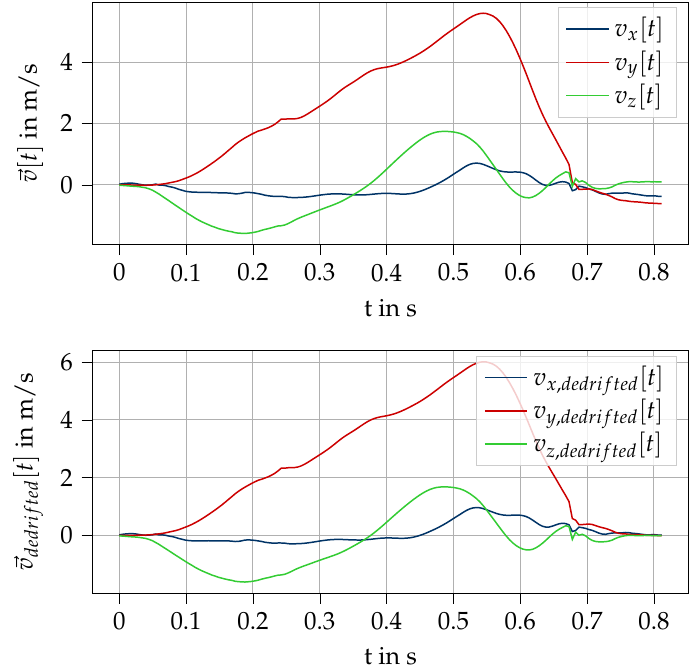
Figure A3. Visualization of the dedrifting of the velocity after the first integration of the acceleration signal for a sample stride of the heel sensor. The upper plot shows the velocity (cid:126) v [ t ] before dedrifting. This signal displays that the velocity at the second midstance ( t = 0.81 s) is not zero. We enforce the velocity to be zero by dedrifing the velocity using a linear dedrifting function. The lower plot shows the velocity (cid:126) v dedrifted [ t ] after dedrifting. Now, the velocity at the second MS is zero in all directions.